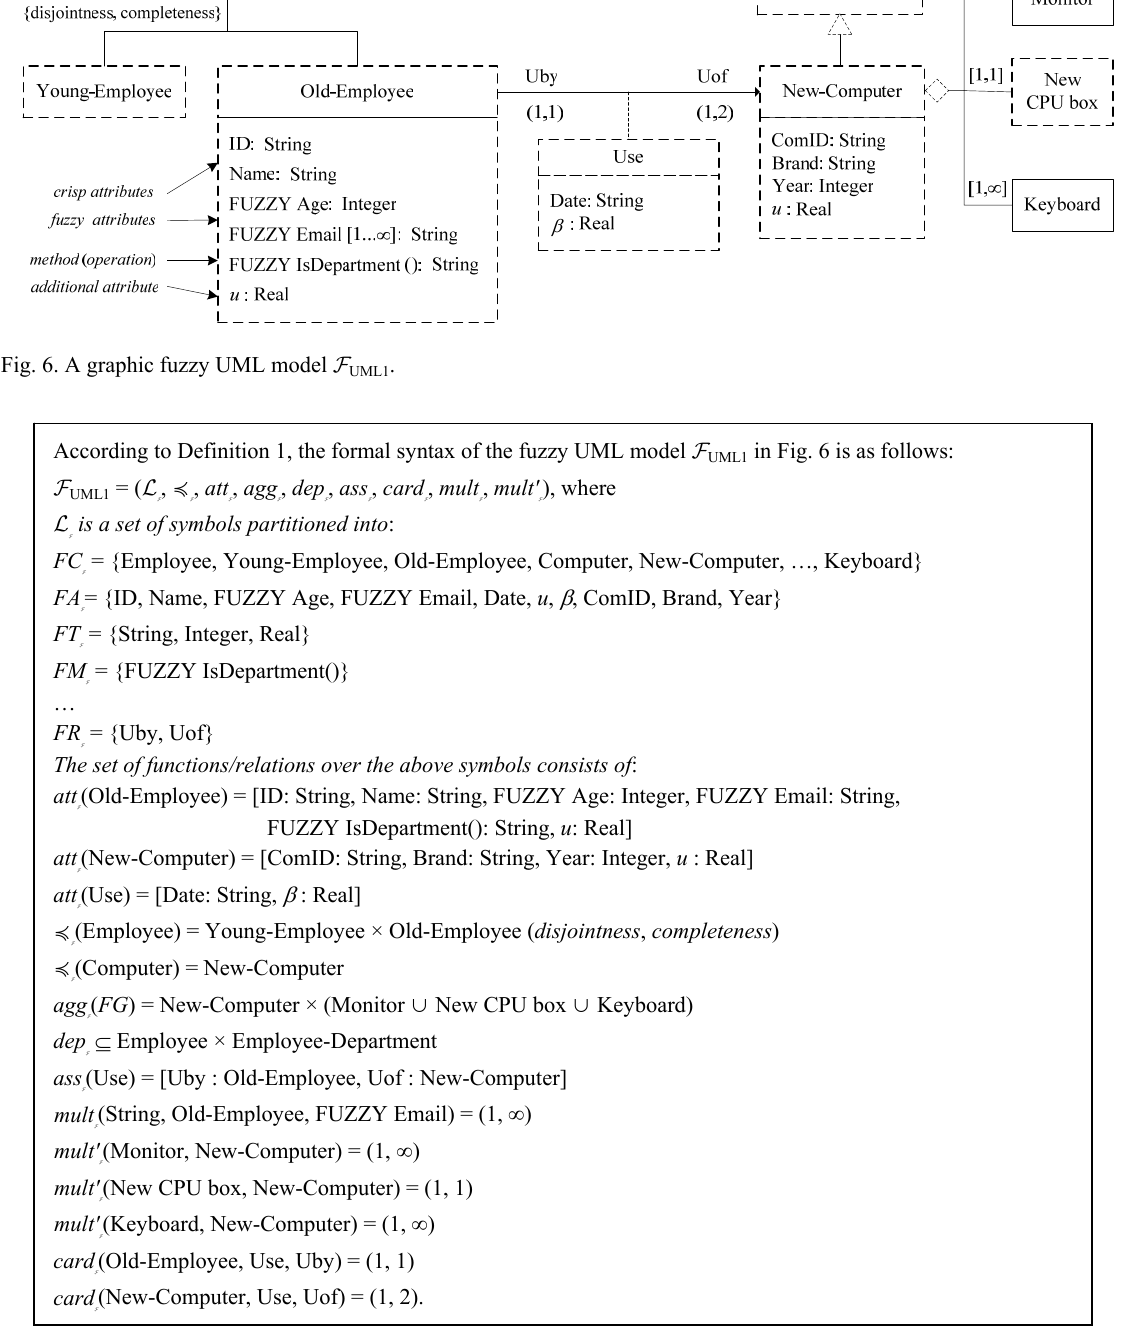
Fig. 7. The formal syntax of the fuzzy UML model F UML1 in Fig.